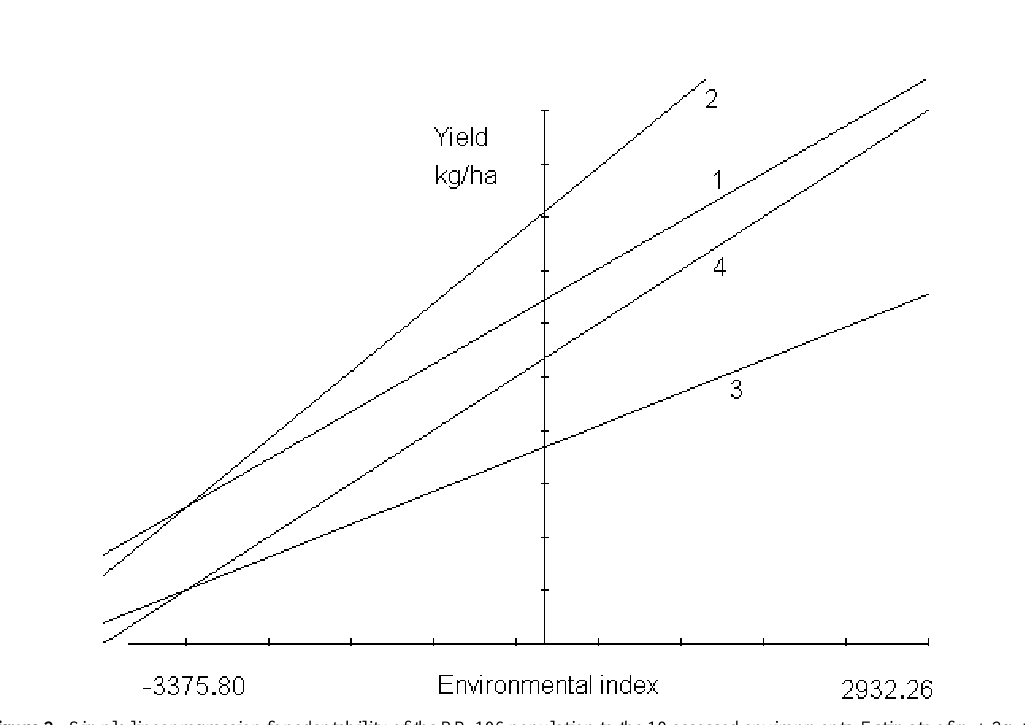
Figure 2 - Simple linear regression for adaptability of the BR-106 population to the 10 assessed environments. Estimate of m + 2g line 1, with b = 0.8909), according to Eberhart and Russell (1966) and its partitioning using Griffing’s (1956) genetic effects: m + 2g 1 b b 1 = 1.2746), m + s ii (line 3, 1 = 0.6163) and m (line 4,